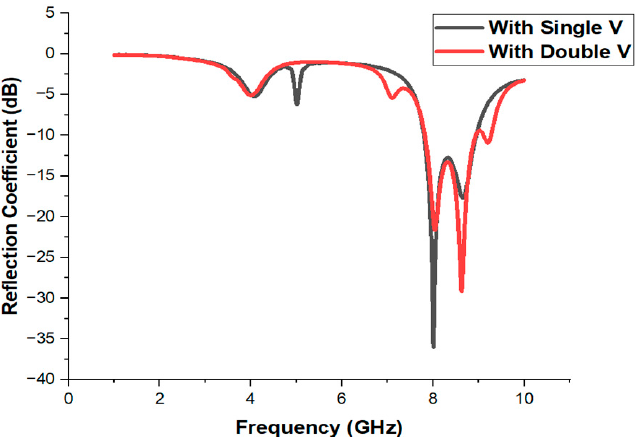
Figure 4. Return loss plot for rectangular patch antenna with two V − shaped extrudes.